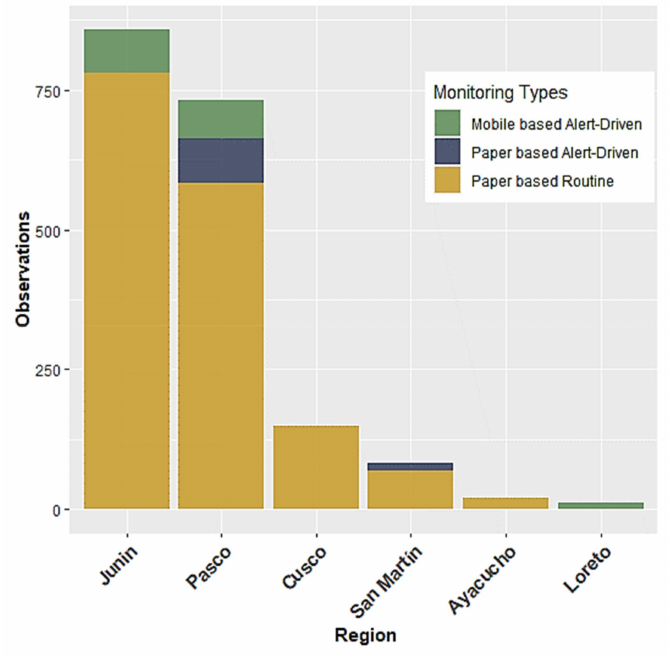
Figure 5. Number of observations per region, where mustard bars indicate routine monitoring, blue bars indicate paper-based alert-driven monitoring, and green indicates mobile-based monitoring.